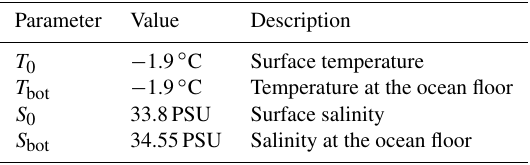
Table 5. Parameters for the COLD profiles. Table 6. Parameters for the WARM